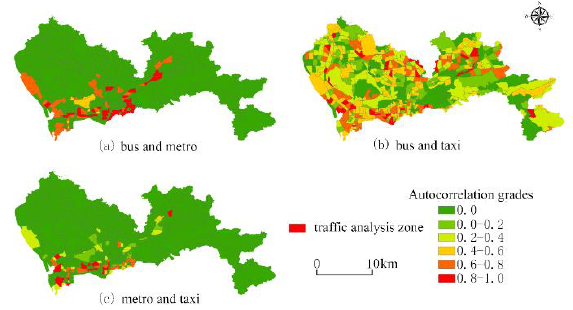
Figure 4. The spatial distribution of correlation